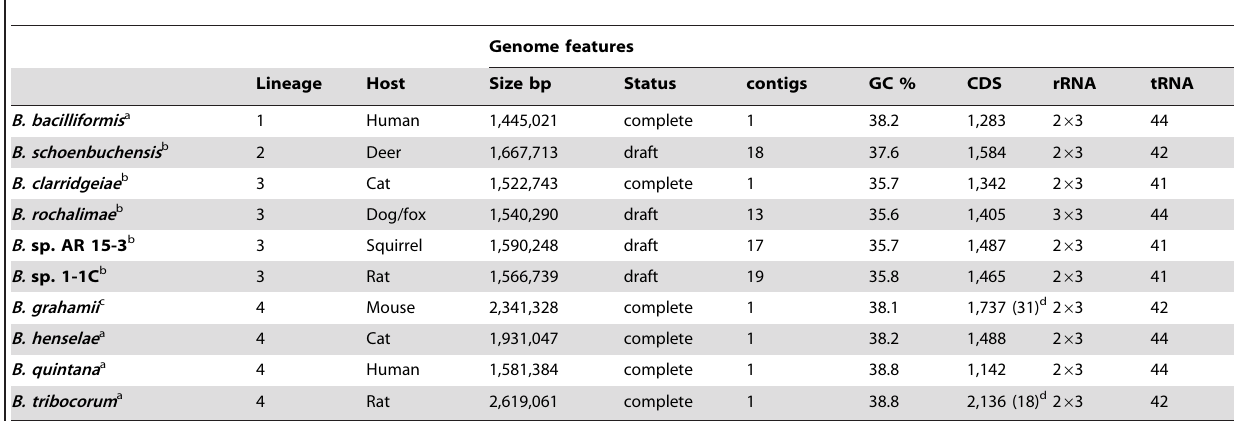
Table 1. Genomic features of analyzed Bartonella species and information about their reservoir host and phylogenetic lineage (see also Figure 1).